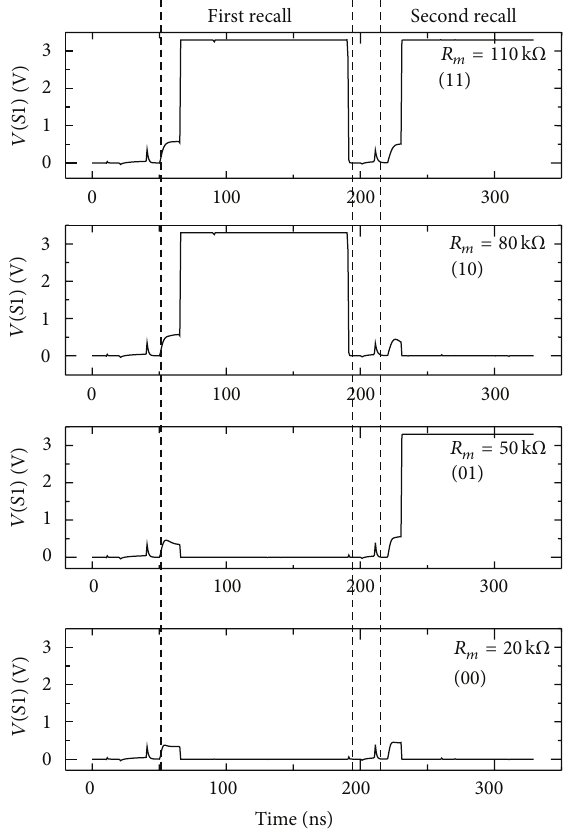
Figure 8: Simulation results for the recall operation. 𝑅 were fixed at 100 and 65 k Ω , respectively.